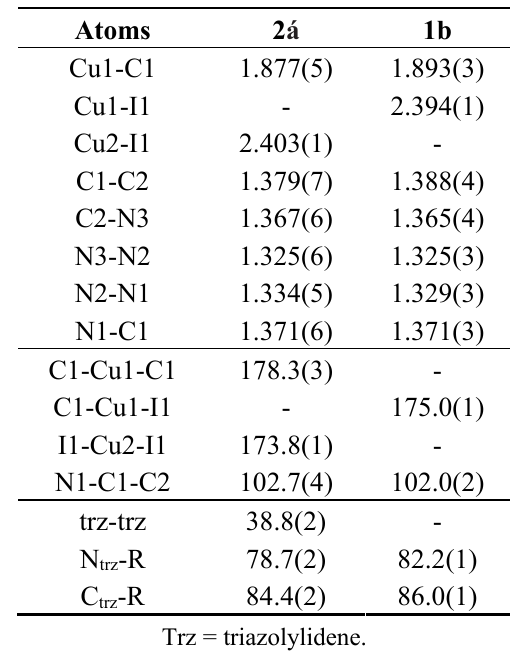
Table 2. Selected bond lengths (Å) and angles (°).